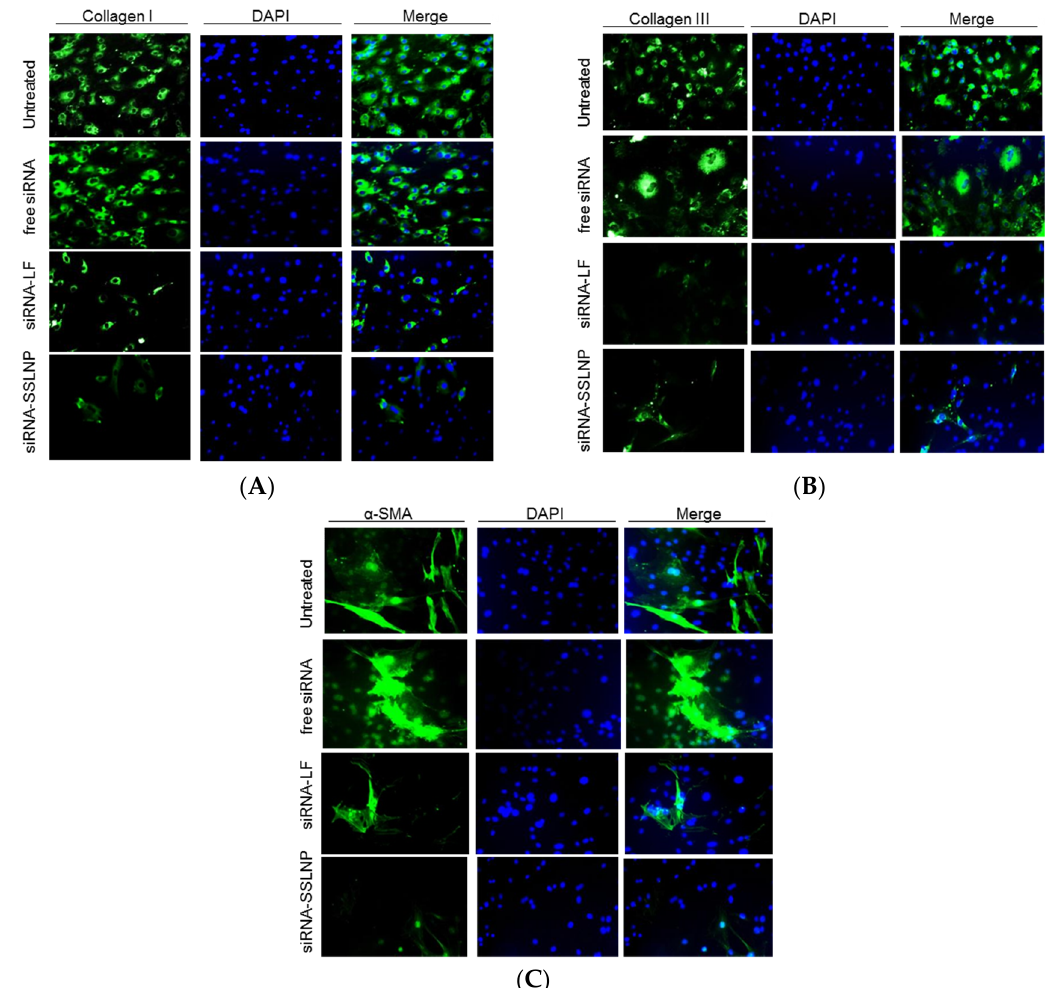
Figure 6. Reversal of primary hepatic stellate cell (HSC) activation: ( A ) Down-regulation of collagen I; ( B ) Collagen III; and ( C ) α -smooth muscle actin ( α -SMA) protein expression indicative of the reversal of activated myofibroblasts to quiescent stellate cells. Activated HSC were transfected with connective tissue growth factor (CTGF-siRNA) in various formulations. Standard immunocytochemistry performed 24 h post-transfection, cells were probed with primary antibodies followed by secondary Alexa-Fluor 488 ( green ) labeled antibody, then DAPI for nuclear staining ( blue ).